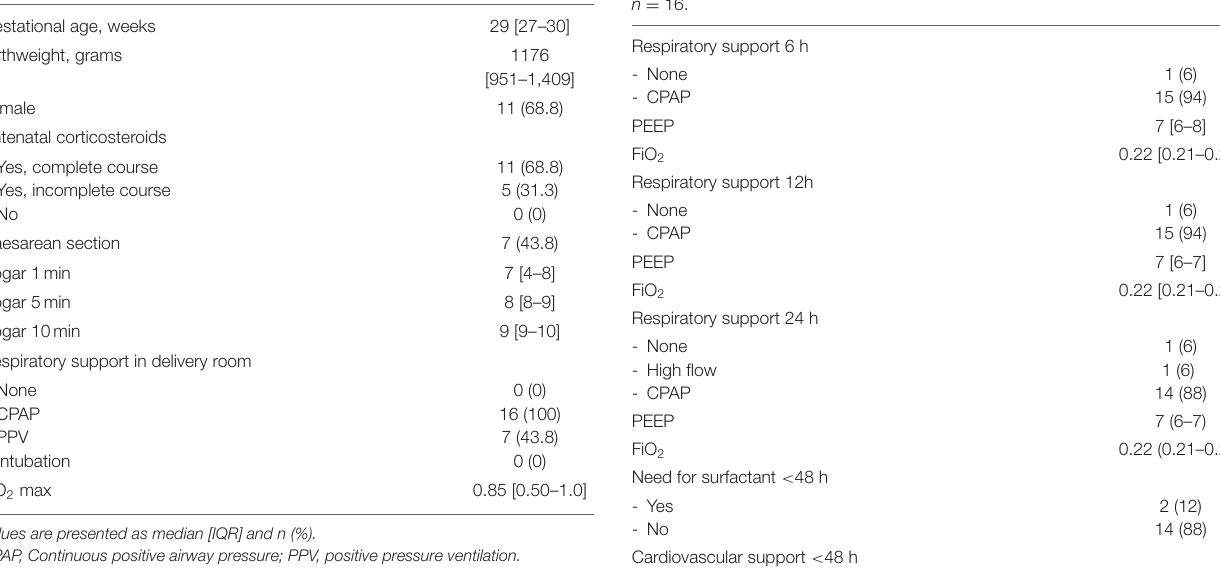
TABLE 1 | Baseline characteristics, n = 16.